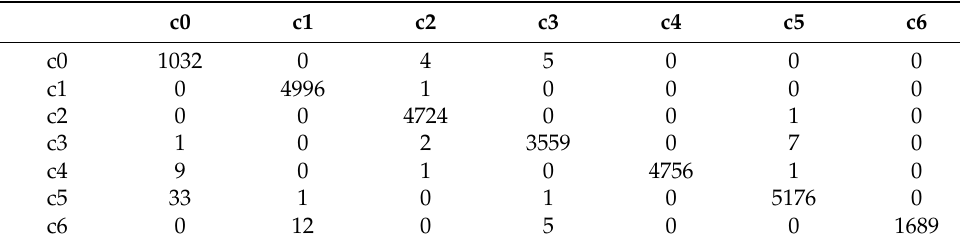
Table 5. Confusion matrix for the distracted driving front data set.